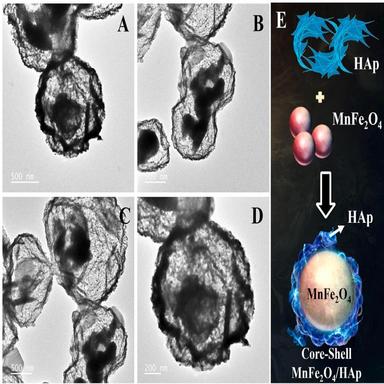
(A–D) HR-TEM images for Core-Shell with different magnifications. (E) Core-shell formation schematic illustration.